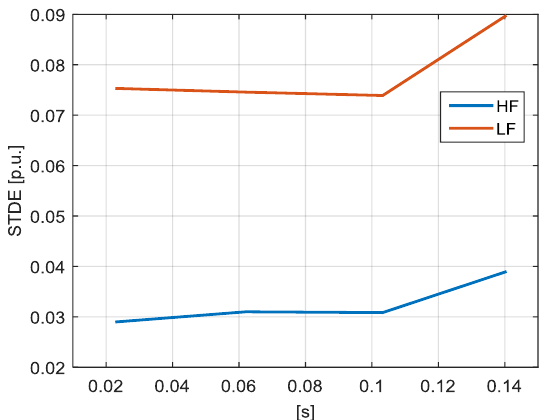
Figure 34. Case study 2: STDE at low-frequency (0 ÷ 2 kHz, red line) and at high-frequency (2 ÷ 150 kHz, blue line) obtained through Prony’s method.